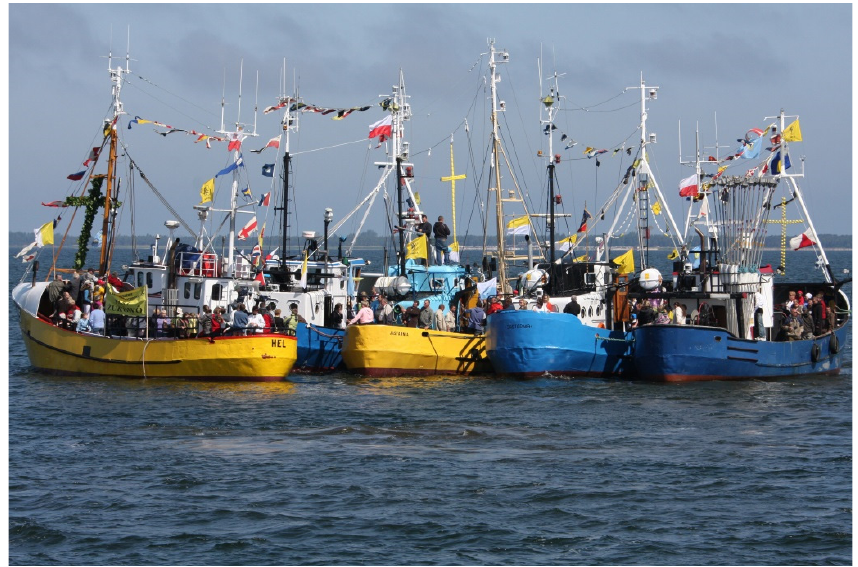
Figure 4. Fishing boats meeting on Puck Bay to participate in a Holy Mass together. Author: (Tadeusz Palmowski 2009).